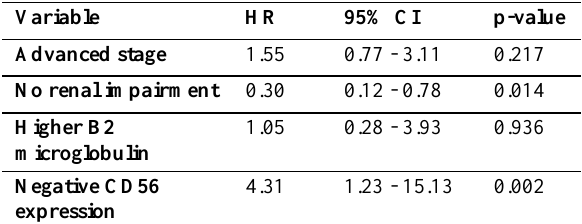
Table 4: Multivariate analysis of overall survival in 50 patients with multiple